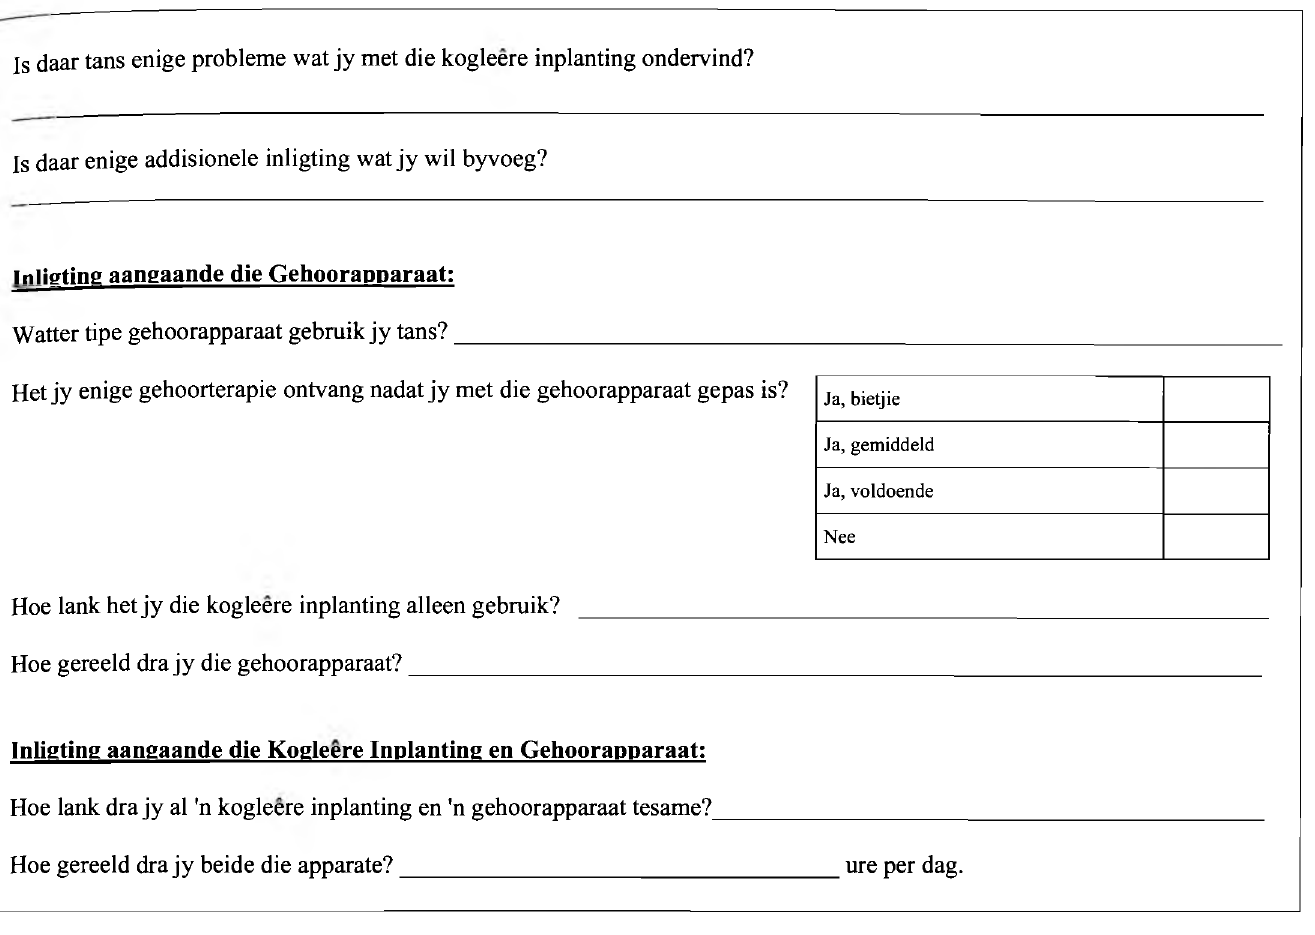
Afdeling B : OUDITIEWE